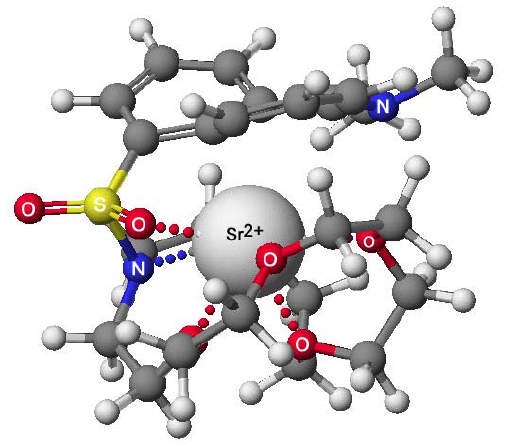
Fig. 9 The optimalized structure of (A18C6-Dns + Sr) 2+ complex.